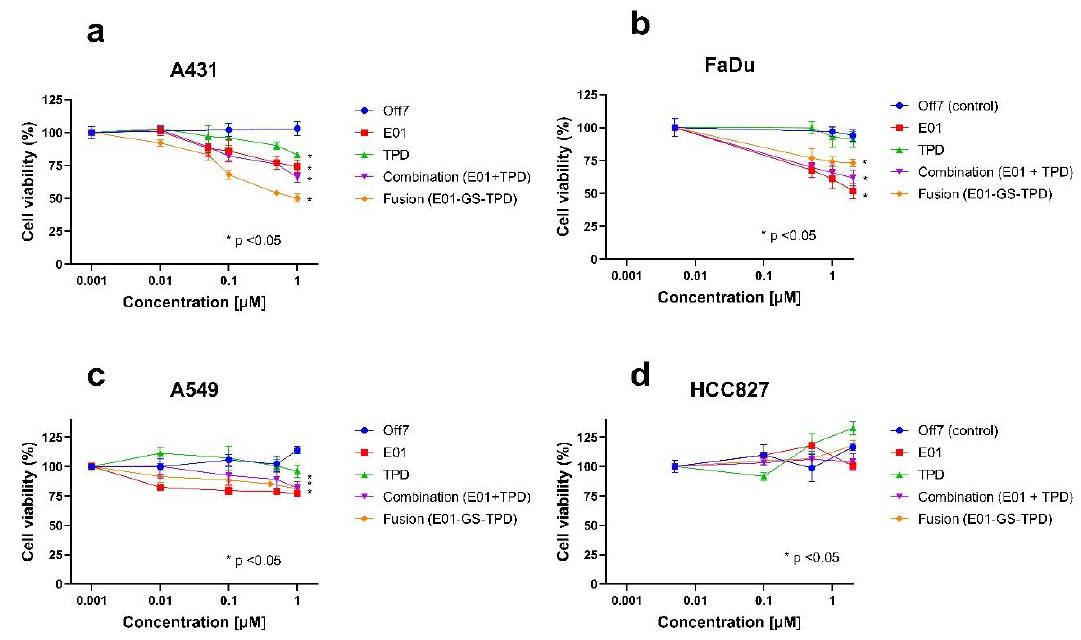
Figure 5. EGFR / ADAM17 inhibition decreases cell proliferation of wild-type EGFR cells. Cell lines were treated with recombinant proteins at the indicated concentrations and allowed to proliferate for 72 h. The largest e ff ects in growth inhibition were observed in the highly overexpressing wild-type EGFR A431 cells ( a ) followed by the wild-type EGFR-positive cell line FaDu ( b ) and the wild-type EGFR, KRAS mutant A549 cell line ( c ). No e ff ects in growth inhibition were observed in the constitutively active EGFR mutant cell line HCC827 ( d ). Mean and standard deviation from n = 3 is shown, significance (* p < 0.05) was calculated using Tukey’s multiple comparisons test and is shown where applicable for the highest concentration of recombinant protein compared to untreated controls.